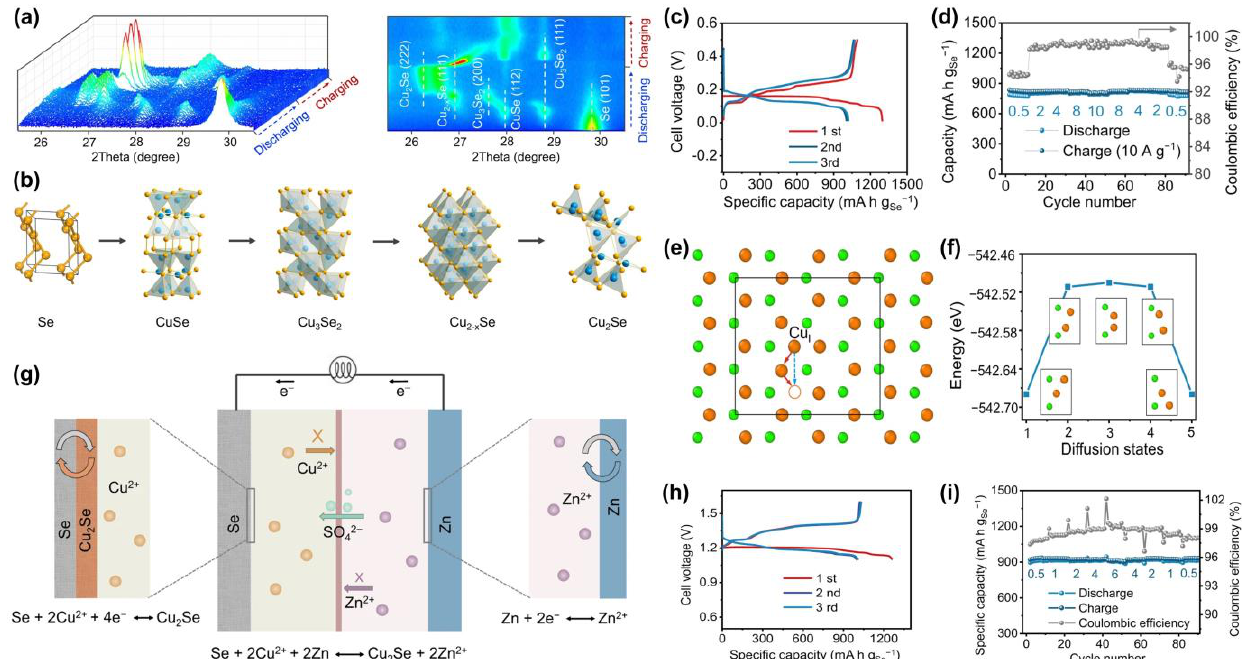
Figure 10. ( a ) In situ XRD patterns and ( b ) structure evolution of the Se cathode in AZSeBs during cycles; ( c ) GCD curves of the initial three cycles and ( d ) fast-charging rate performance of the Cu||Se cell; ( e ) the top view of CuSe with a Cu 2+ embedded; ( f ) energy barrier of Cu 2+ diffusion in CuSe; ( g ) schematic of the Zn||Se full cell; ( h ) GCD curves of the initial three cycles and ( i ) fast-charging rate performance of the Zn||Se full cell (reproduced with permission from Ref. [68]. Copyright 2022, Springer